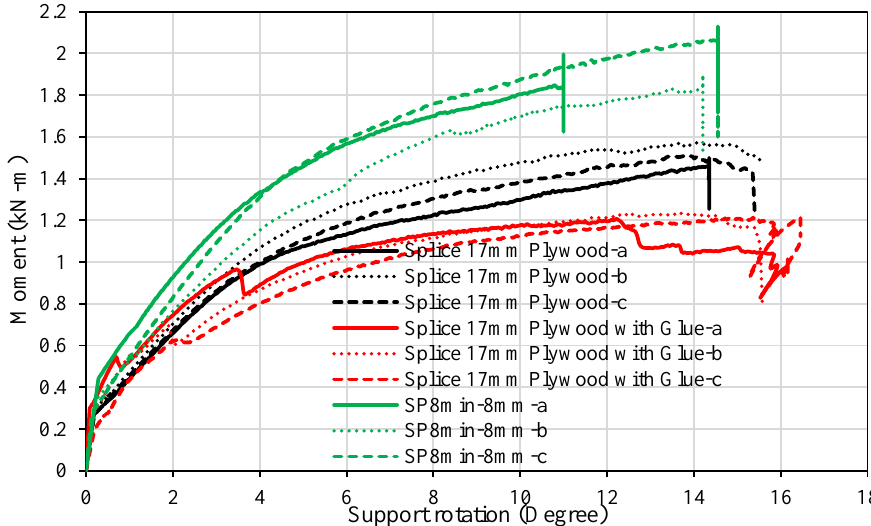
Figure 16. Moment–rotation curves of spline connections with different types of spline plates.